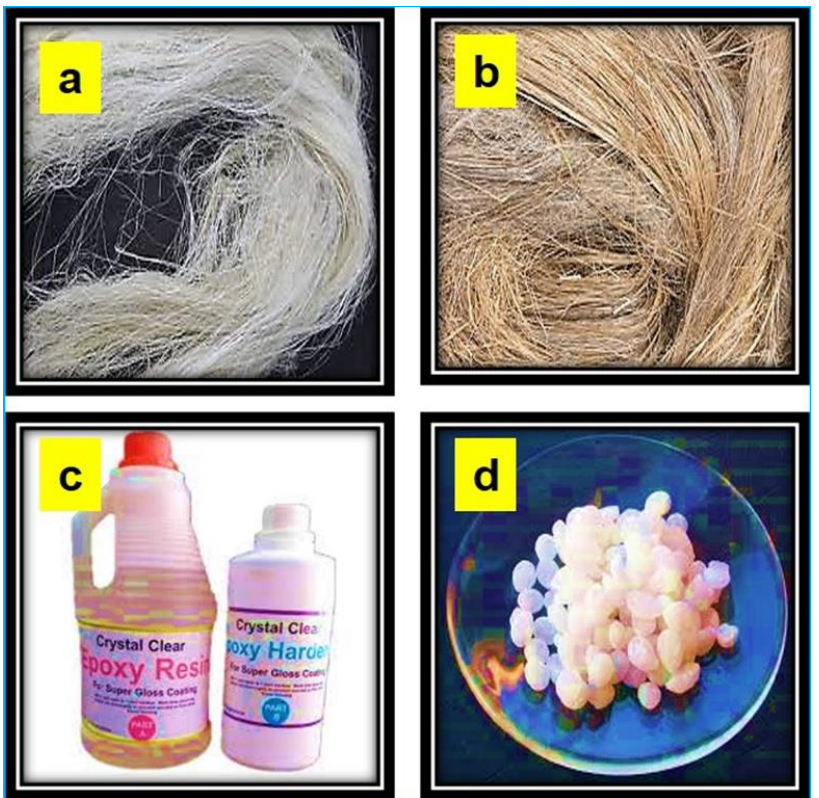
Figure 1. Photographic Images of ( a ) sisal fibre; ( b ) flax fibre; ( c ) Epoxy matrix; and ( d ) NaOH pal-